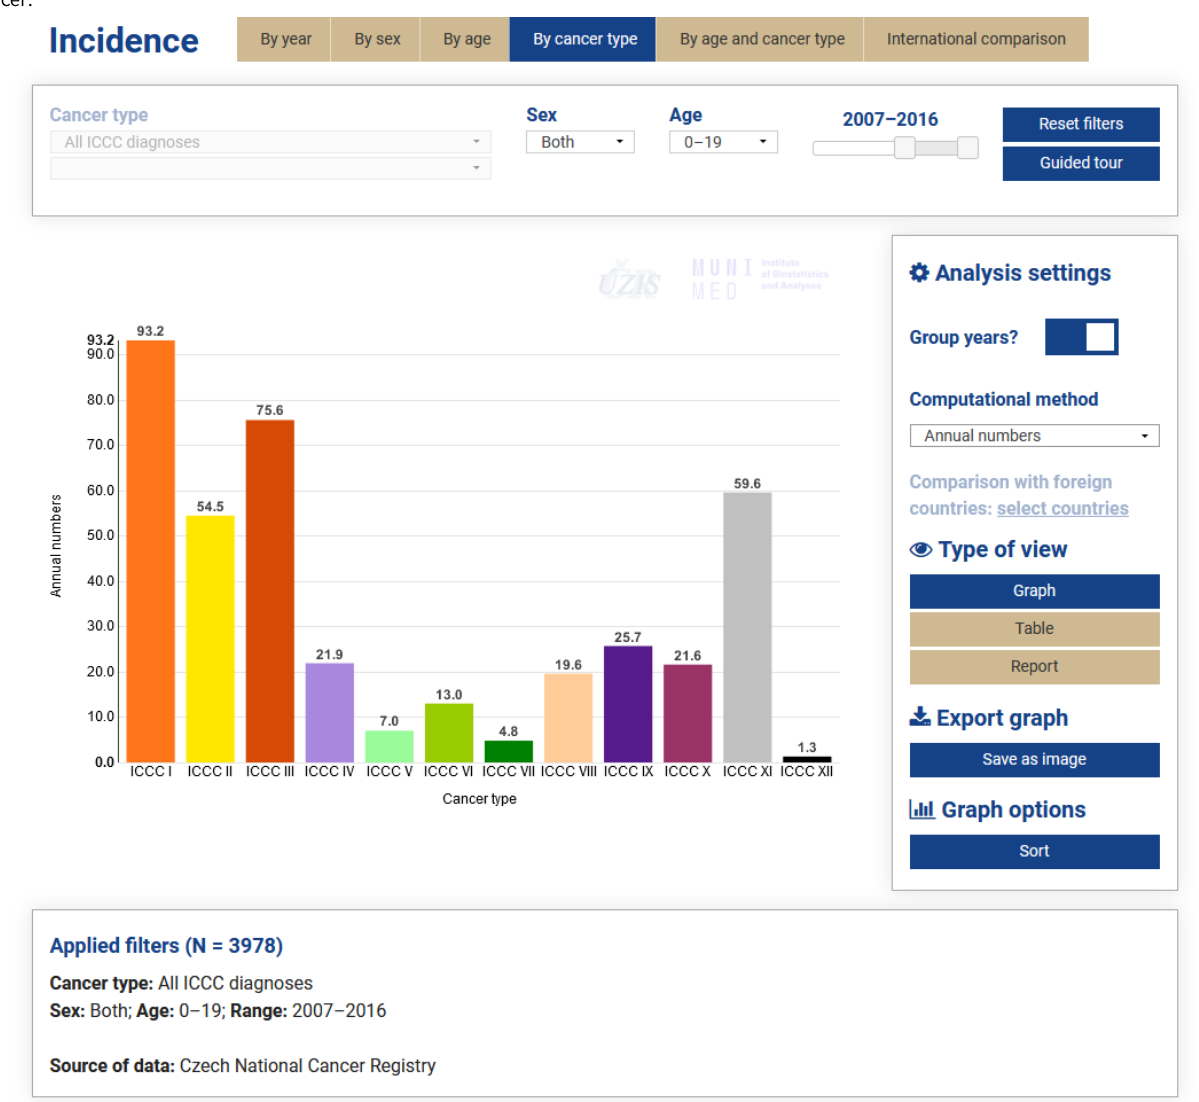
Figure 1. Czech Childhood Cancer Information System Interactive data views, incidence by cancer type. ICCC: International Classification of Childhood